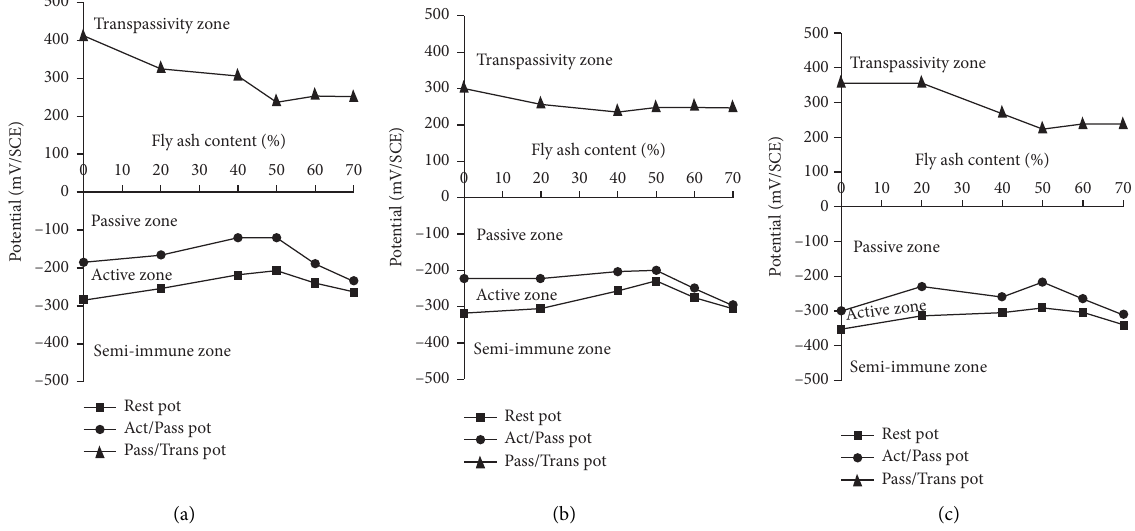
Figure 5: Potential versus different fly-ash content for w/b ratio of 0.35. (a) CRS. (b) Tata TMT. (c) Local